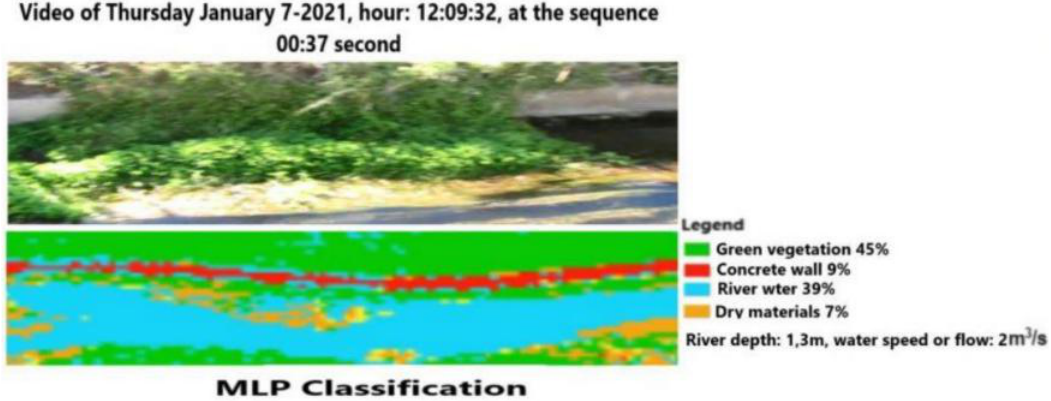
Figure 19. Video frame classification based on MLP at 12:09:32 and the successive